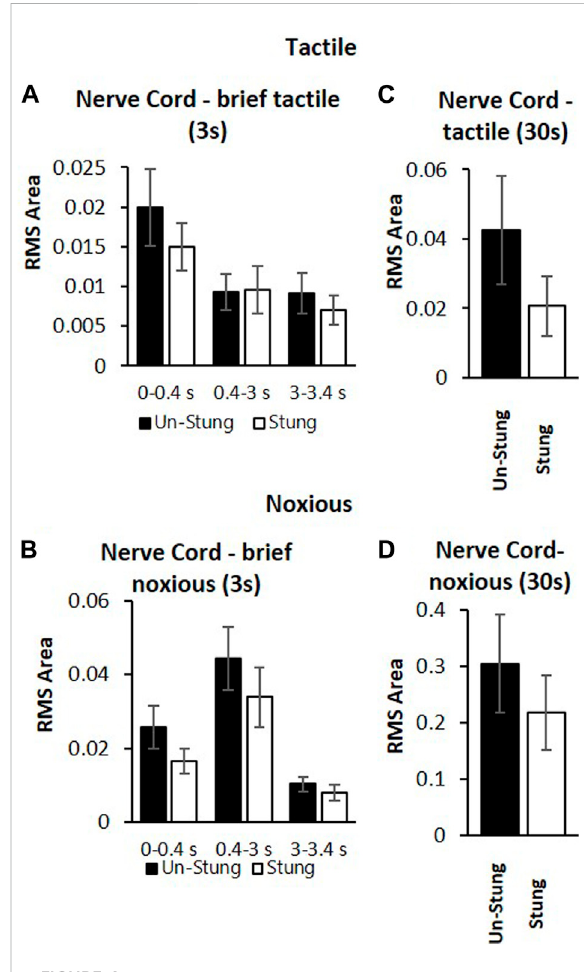
Post-synaptic inter-neuronsinthenervecordofstung (white bars) and un-stung (black bars) cockroaches are similarly active in response to both tactile stimuli and noxious stimuli. (A) Averaged RMS area of nerve cord response of un-stung (n = 20) and stung cockroaches (n = 9) to brief (3s) tactile stimuli. Panel (B) Averaged RMS area of the nerve cord response of un-stung (n = 20) and stung cockroaches (n = 9) to brief (3s) noxious stimuli. Panel (C) Averaged RMS area of the nerve cord response of un- stung (n = 13) and stung cockroaches (n = 7) to 30s tactile stimuli. Panel (D) Averaged RMS area of the nerve cord response of un- stung (n = 13) and stung (n = 7) cockroaches to 30 s noxious stimuli. For all panels, bars represent means ± SEM; signi fi cance is indicated with an asterisk (no signi fi cance was